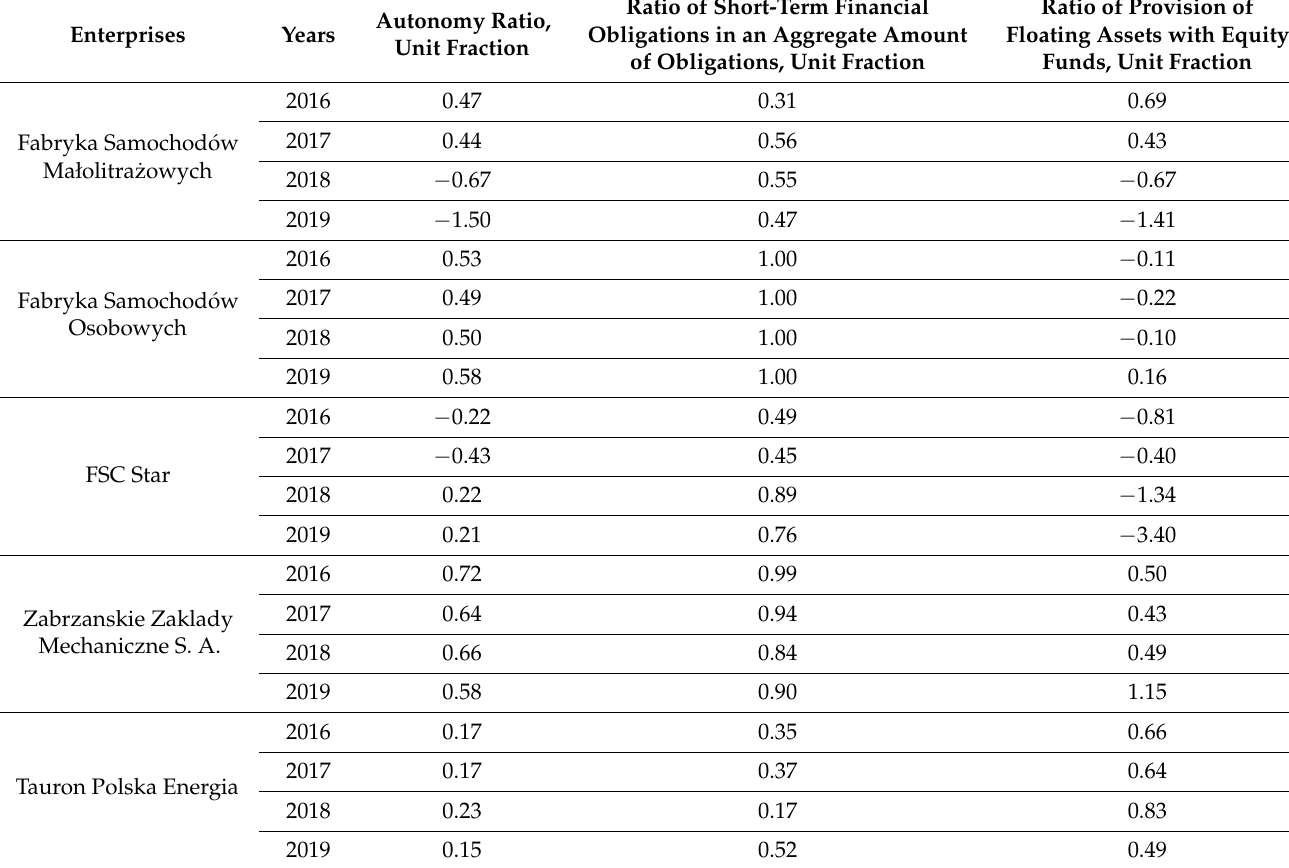
Table A1. Indexes of financial firmness and independence of the